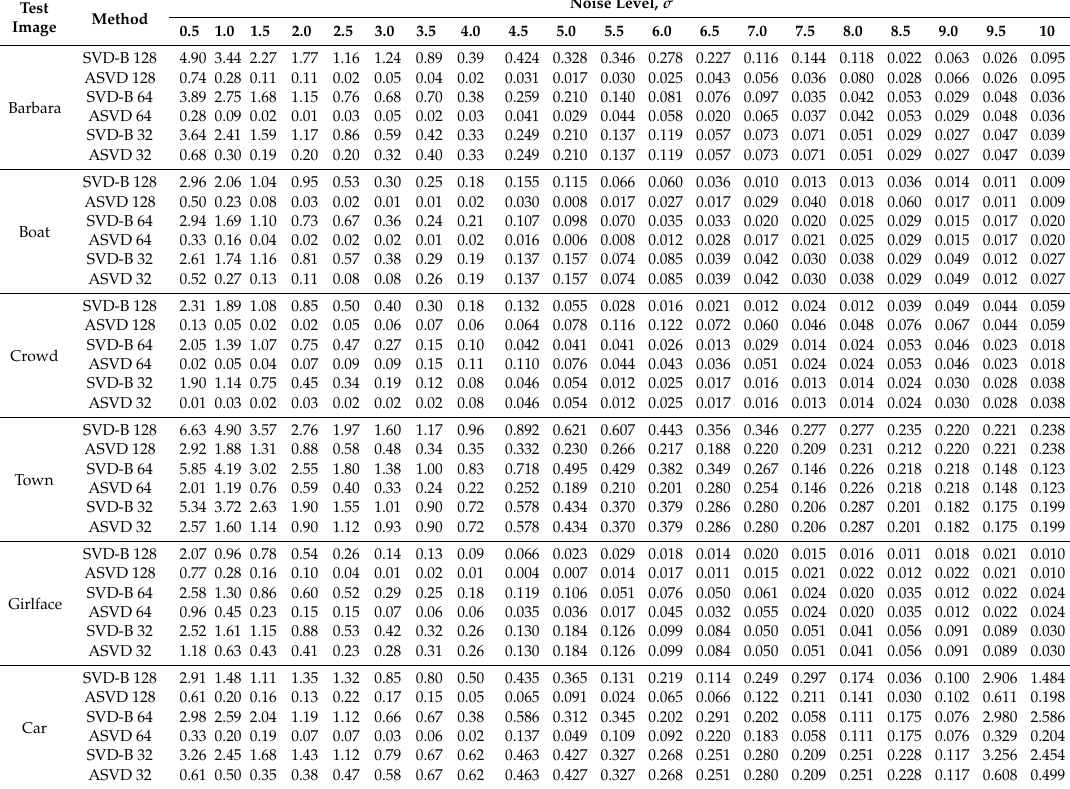
Table 4. Mean square error (MSE) levels for a range of noise levels and test